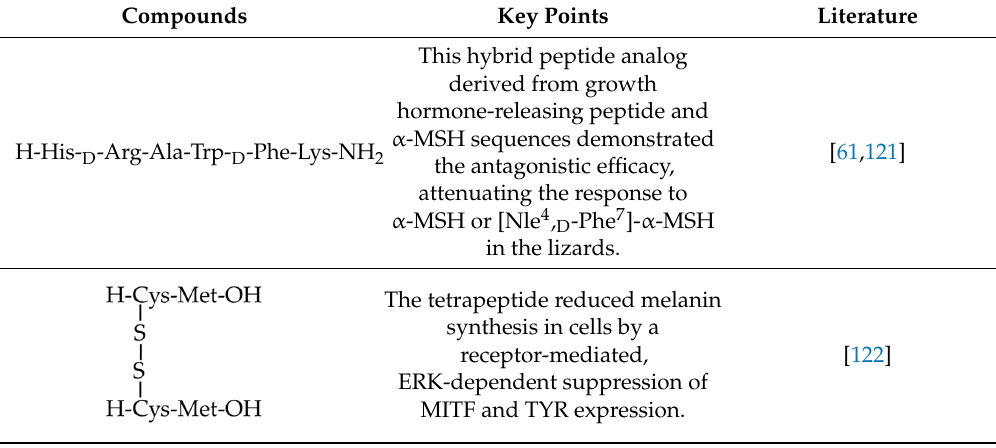
Table 5. Peptides that reduce TYR gene expression or its protein level in melanocytes. Compounds Key Points